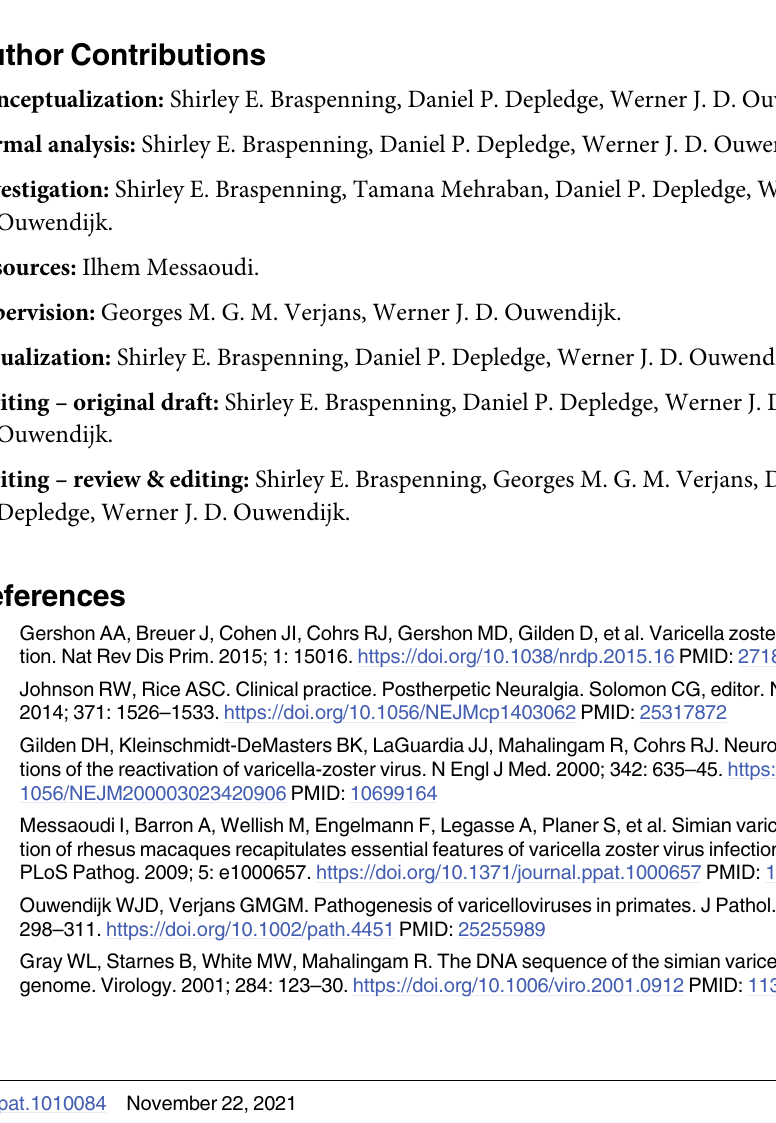
S1 Table. Overview of sequence datasets. S2 Table. TSS and CPAS sites identified within the SVV genome. S3 Table. Complete SVV reannotation and coding potential. S4 Table. Comparison between SVV Delta-EMC and current SVV Delta GenBank refer- ence sequence (NC_002686.2). S5 Table. Primers used in this study. S6 Table. Abundance of transcript isoforms in LLC-MK2 and CM